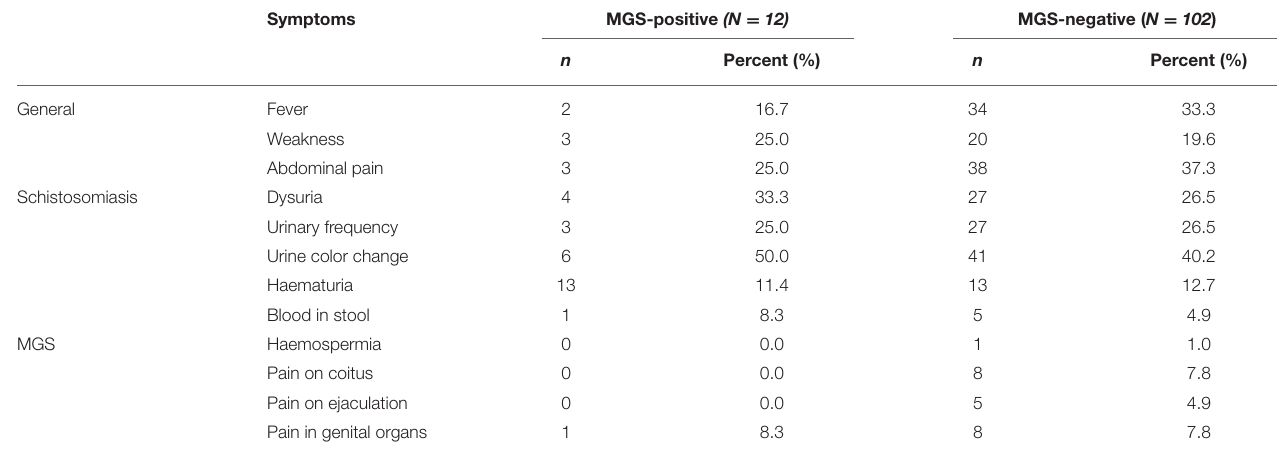
TABLE 6 | Comparison of 114 participants who reported experiencing symptoms of schistosomiasis according to the MGS infection